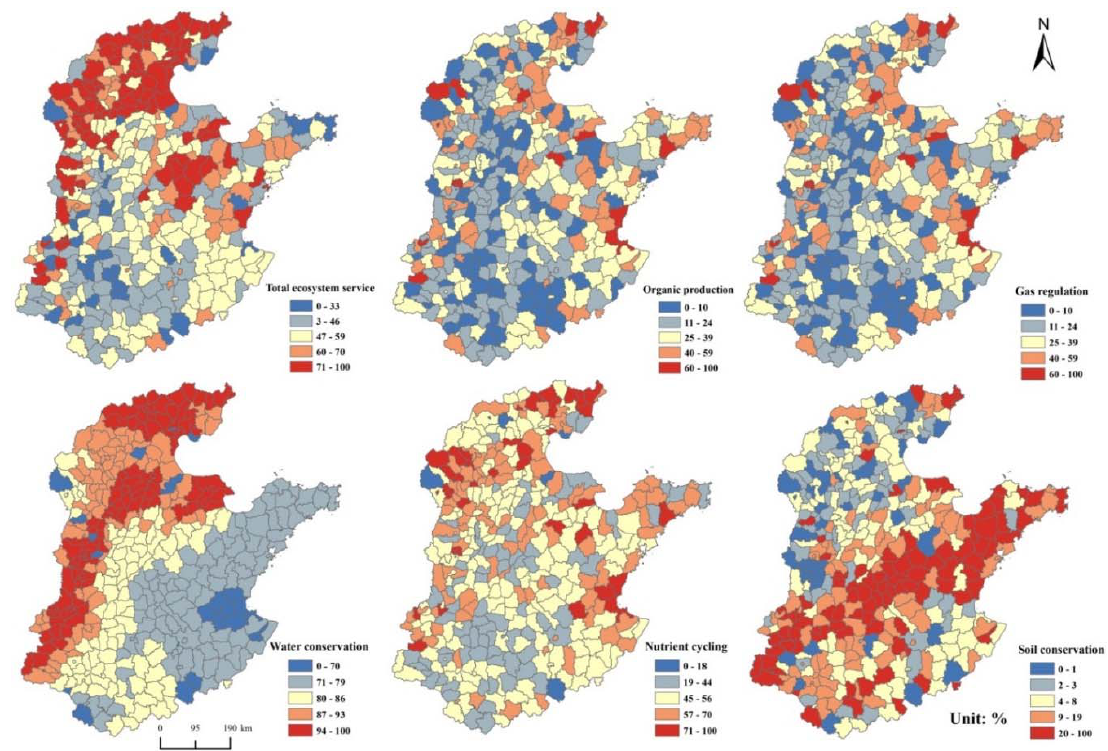
Figure 6. Contribution of land use change in driving ESV change in the